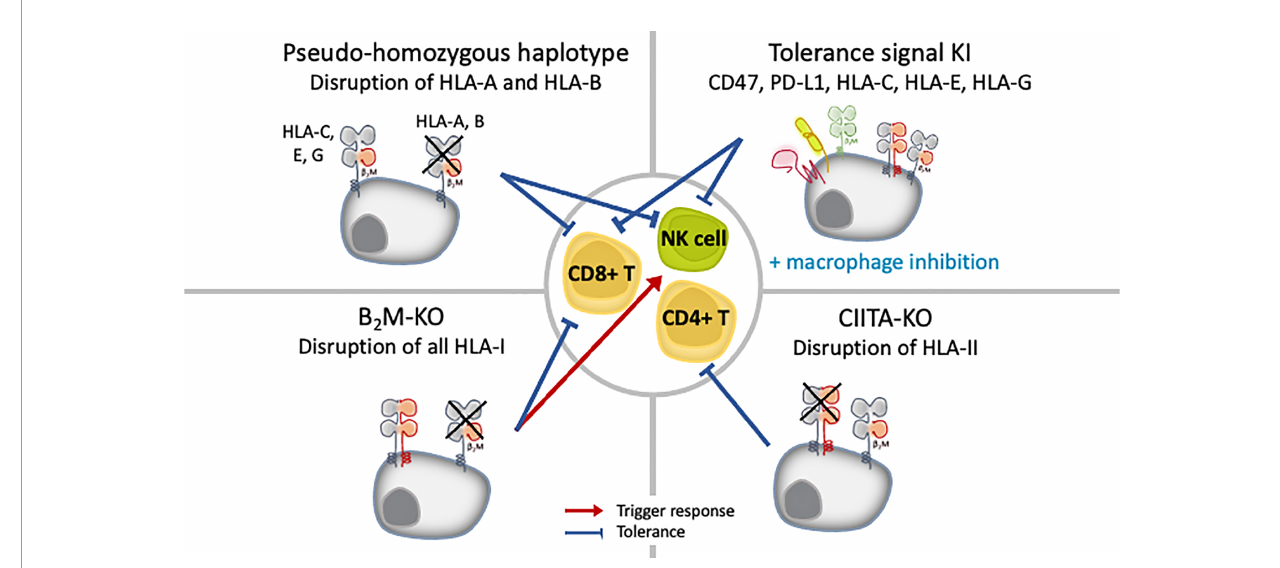
FIGURE 3 | iPSC engineering strategies to inhibit allogeneic immunity and promote